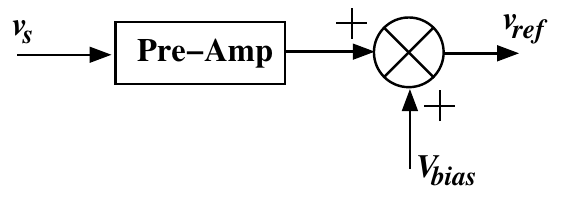
Figure 1. SCS block diagram.